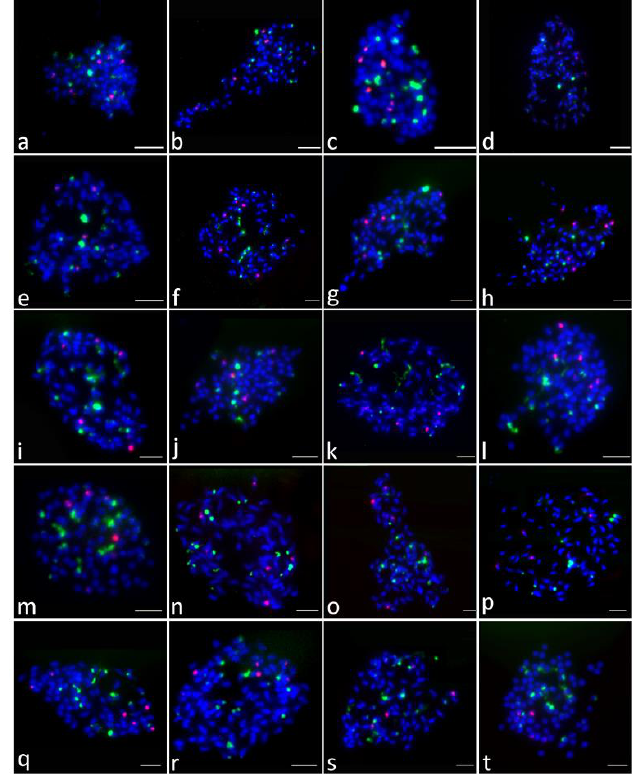
Figure 4. Distribution of 45S (green) and 5S (red) rDNA sites detected by FISH in the remain 20 purple